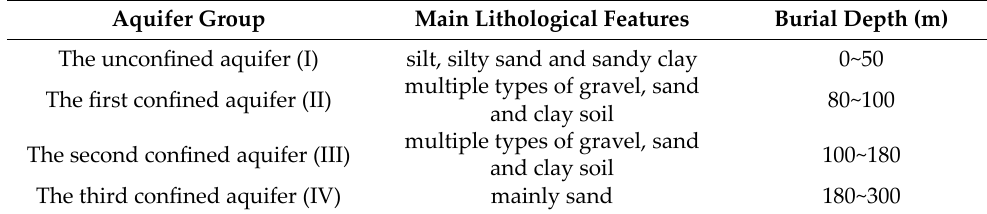
Figure 1. Shaded relief map of the eastern Beijing plain, where major rivers (blue solid lines), main active faults (black dashed lines), GPS stations (black triangles), leveling benchmarks (black dots) and the county boundary of Beijing administrative district (gray dashed lines) are all represented. The red polygon shown in the inset on the top-right corner indicates the location of Beijing and the black box illustrates the study area in this paper. Table 1. The detailed information of aquifer groups in the study